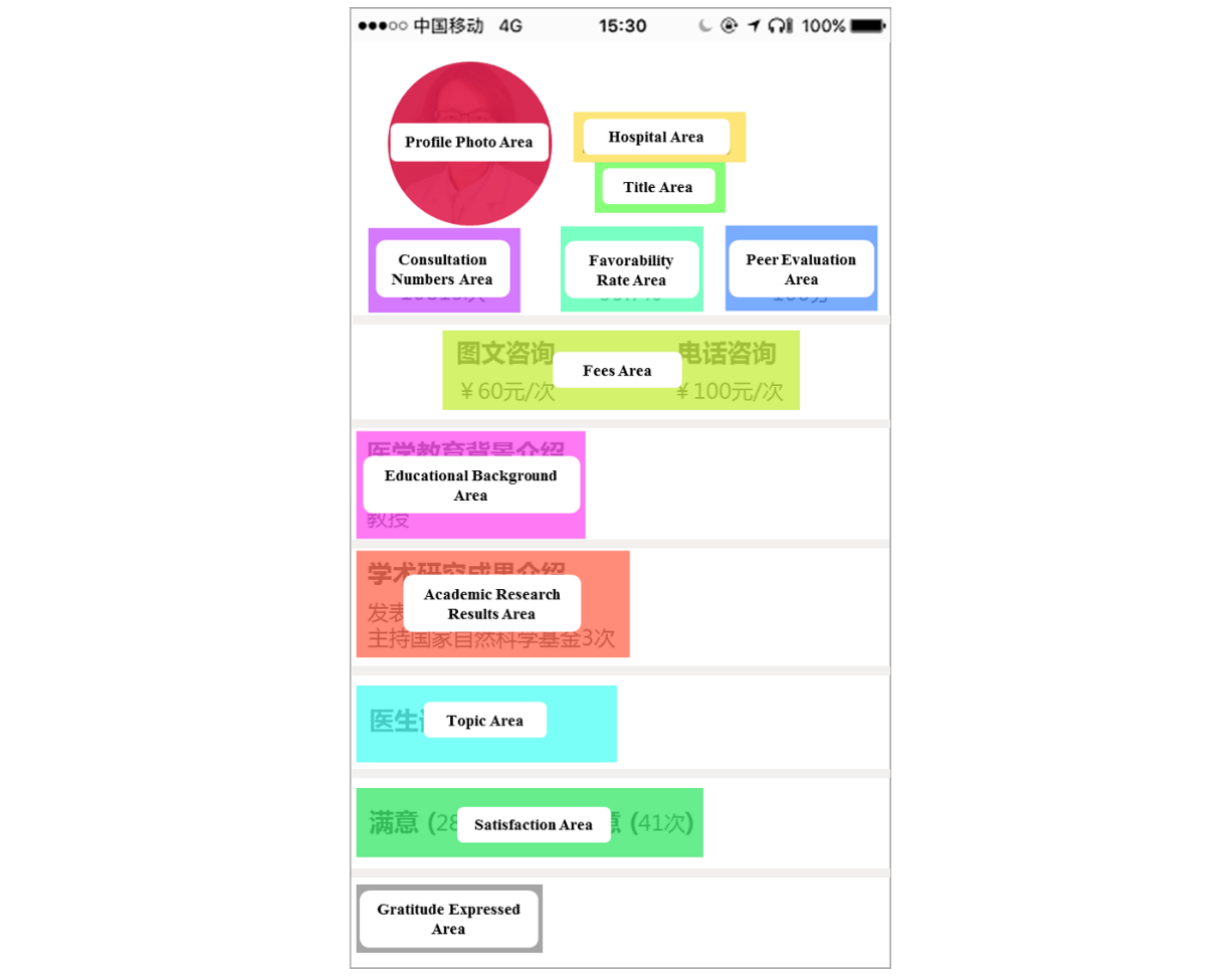
Figure 2. Area of interest division map of physician home pages.